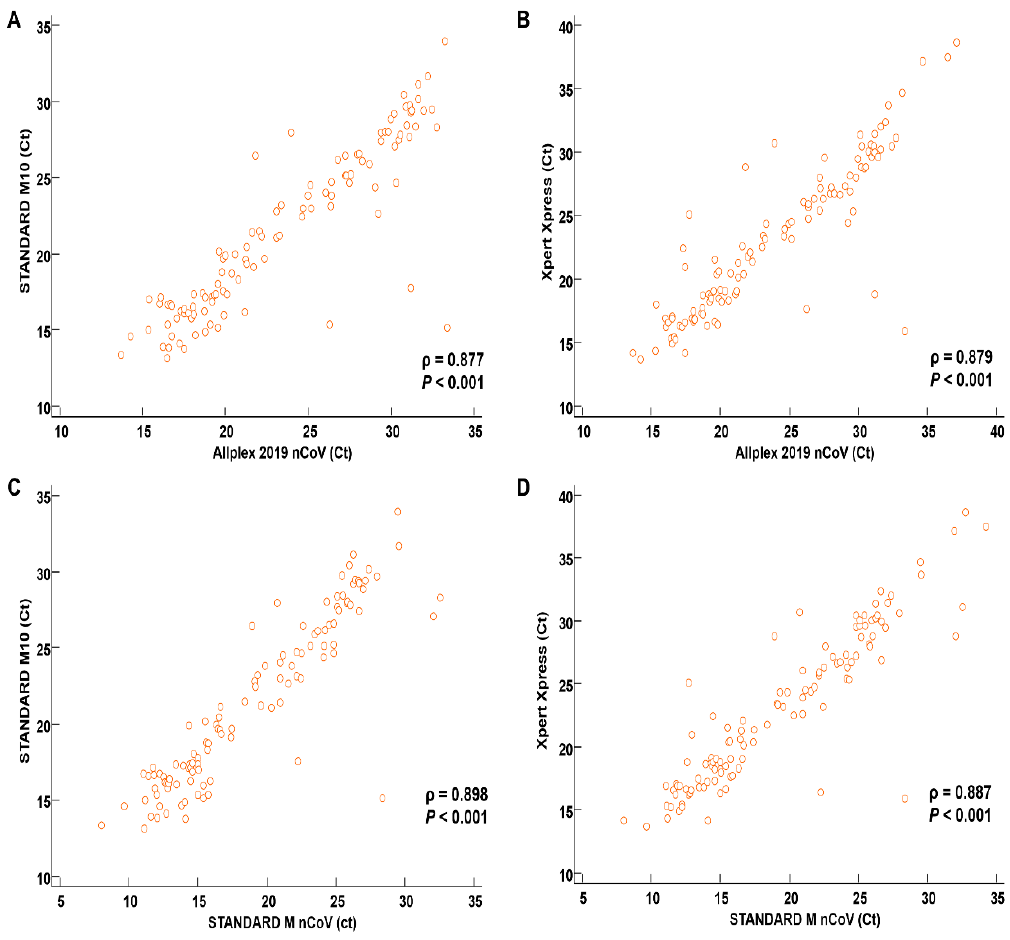
Figure 1. Correlations between E gene Ct values of two rapid RT-qPCR assays and conventional RT-qPCR assays. ( A ) Allplex SARS-CoV-2 vs. STANDARD M10 SARS-CoV-2; ( B ) Allplex SARS-CoV-2 vs. Xpert Xpress SARS-CoV-2; ( C ) STANDARD M nCoV vs. STANDARD M10 SARS-CoV-2; ( D ) STANDARD M nCoV vs. Xpert Xpress SARS-CoV-2. Ct, cycle threshold. Table 4. Ct values of each gene of SARS-CoV-2 assay obtained using the AccuPlex SARS-CoV-2 variant Panel 1.